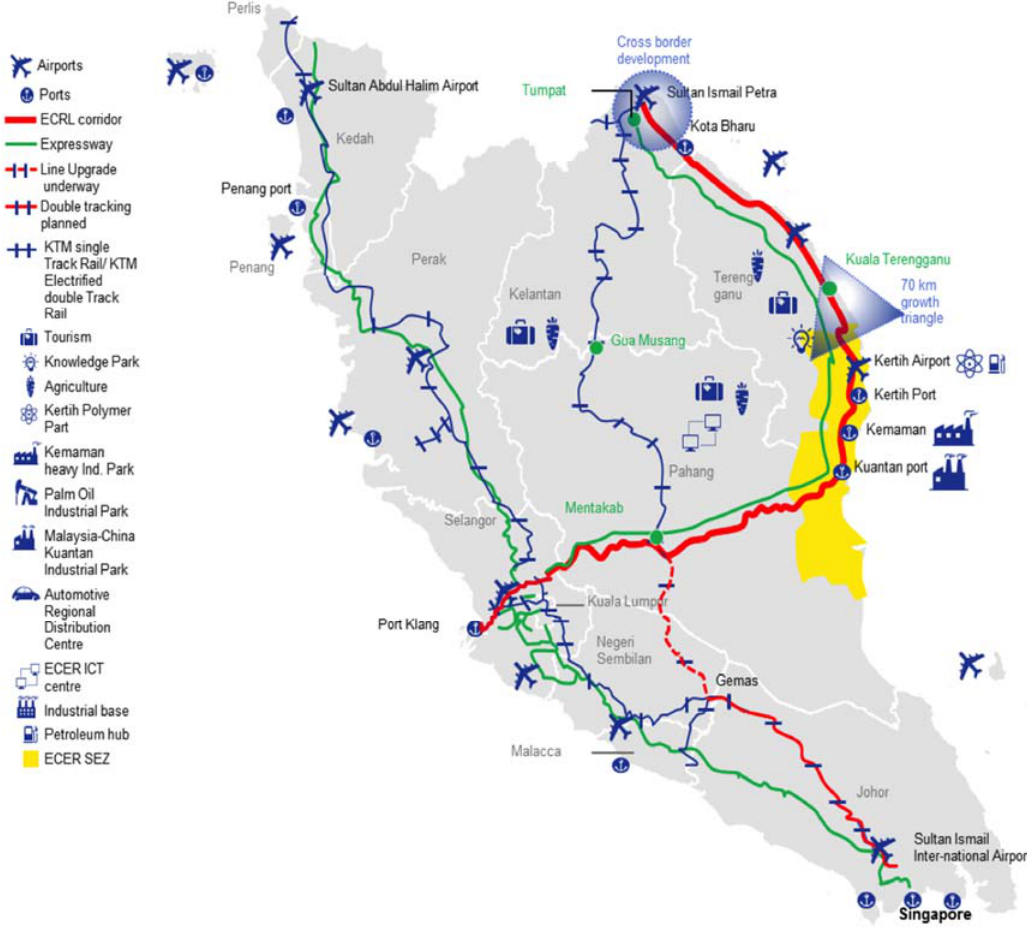
Figure 4. Malaysia rail map (courtesy: SPAD).